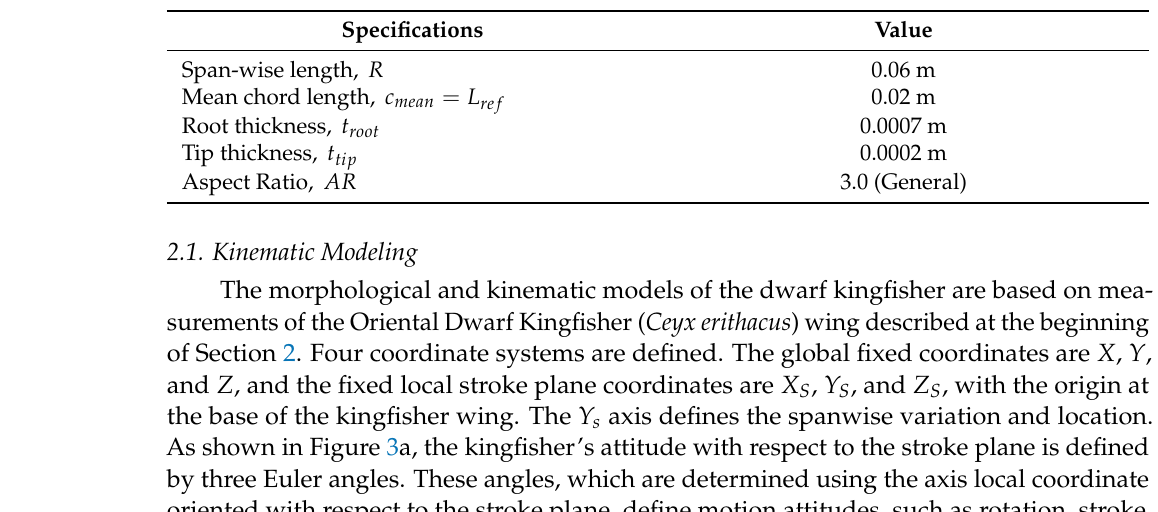
Table 1. Kingfisher-inspired wing model specifications.